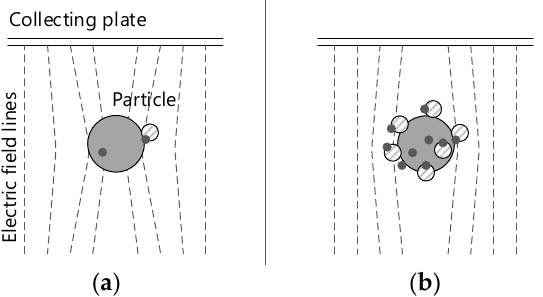
Figure 7. Particle charging by the field mechanism, and its effect on the electric field lines; ( a ) unsatu- rated particle; ( b ) saturated